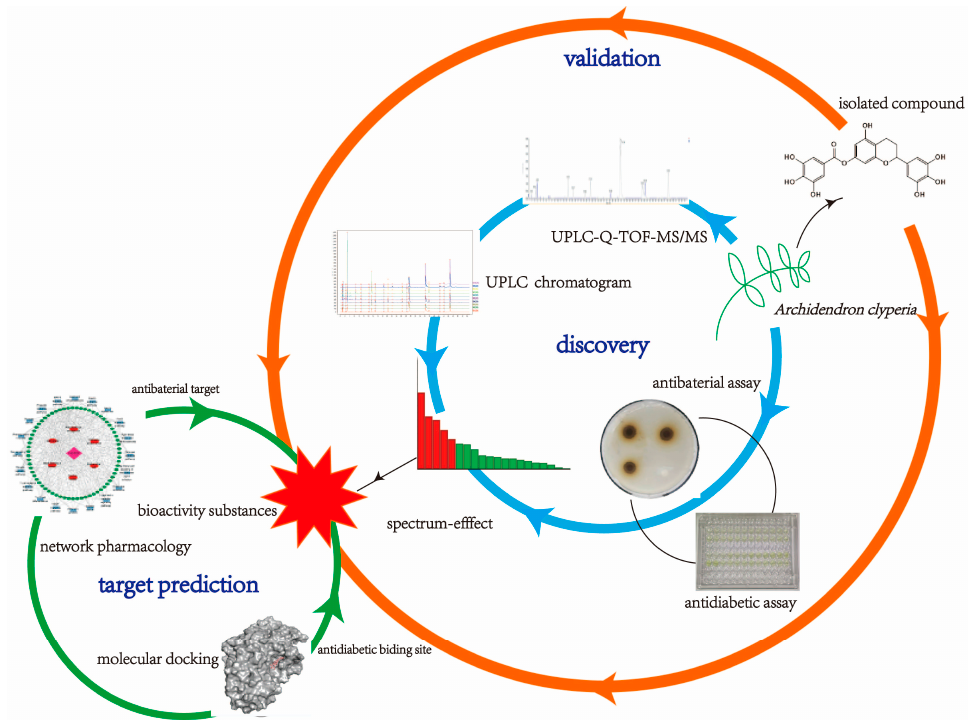
Figure 2 . Strategy for studying the antibacterial and antidiabetic components extracted from A. clypearia.